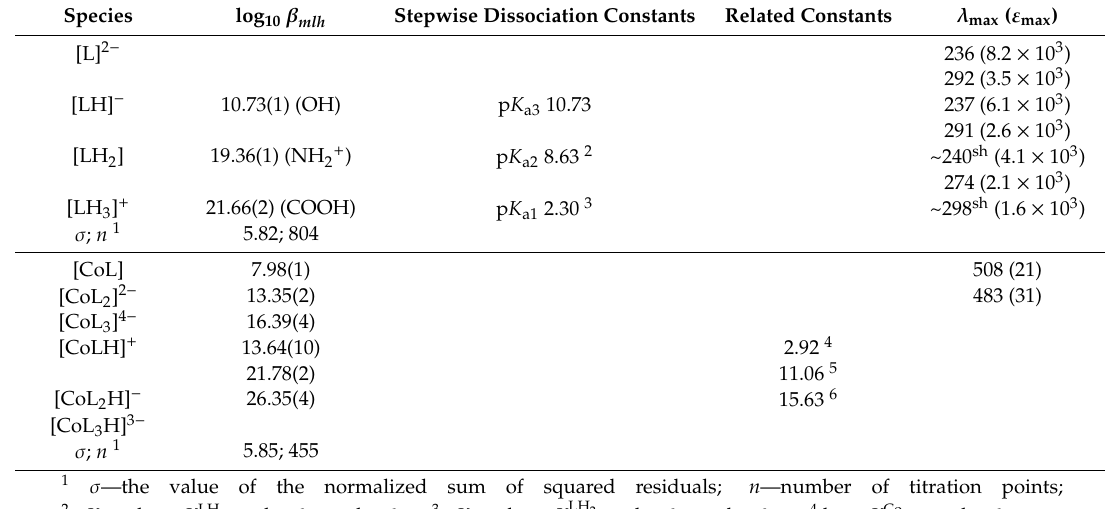
Table 1. Decimal logarithms of overall protonation and formation constants in the Co(II) −